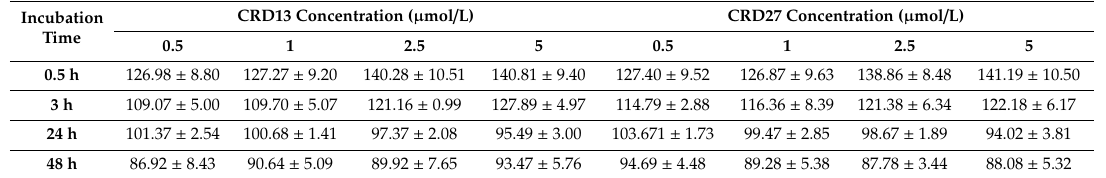
Table 2. Changes in reactive oxygen species (ROS) levels in 1301 cells under the influence of ruthenium dendrimers CRD13 and CRD27. The values are mean ± SD.